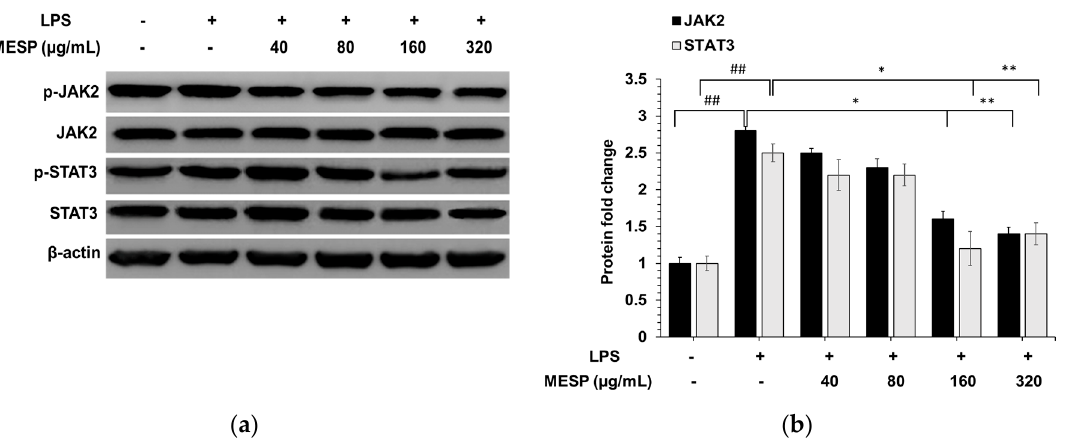
Figure 5. Inhibitory effects of MESP on JAK2/STAT3 pathway activation. Immunoblot analysis of JAK2 and STAT3 protein levels ( a ) and quantification of protein levels ( b ) normalized to β -actin. ## p < 0.01, compared to the control group; * p < 0.05, ** p < 0.01, compared to the LPS treated group.